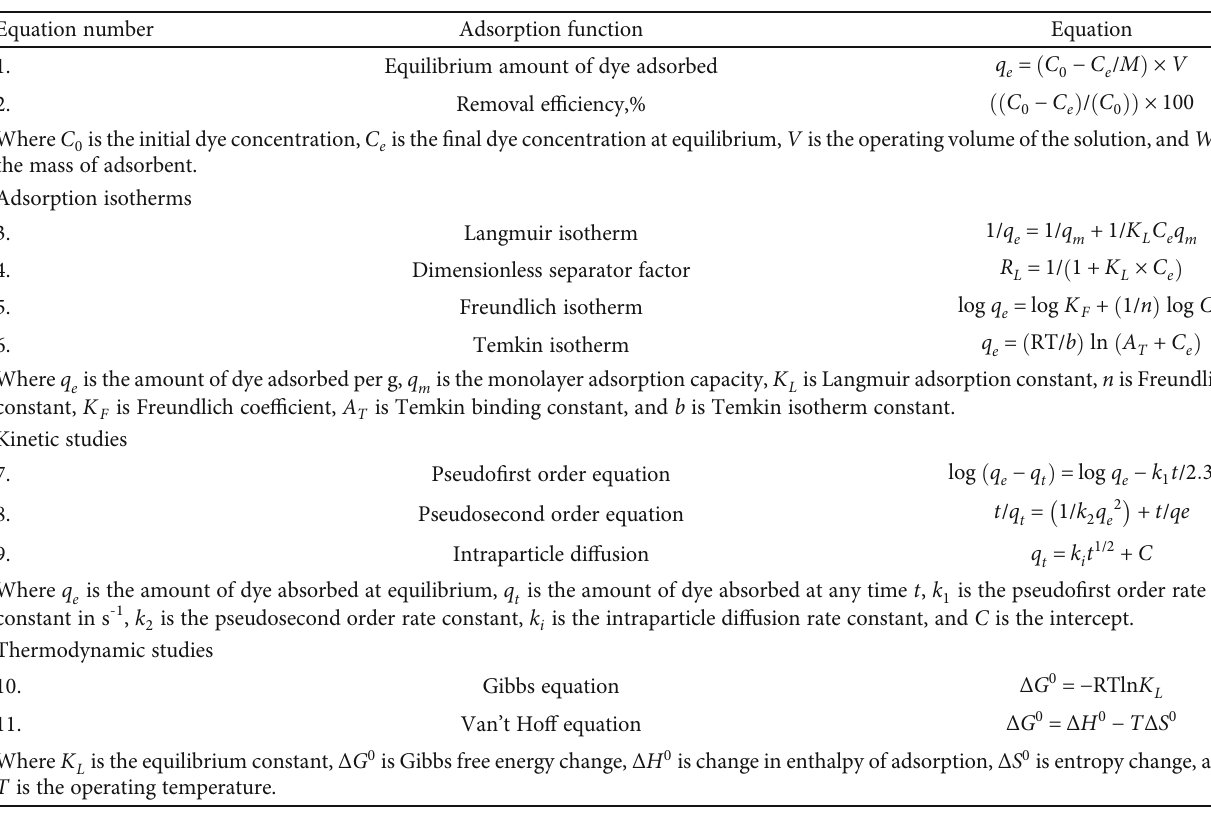
Table 1: Equations of adsorption